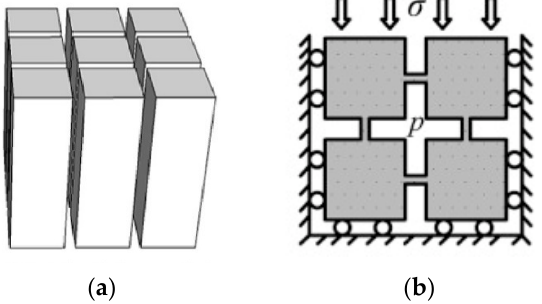
Figure A1. Simplified model of the coal and idealized boundary conditions in a CBM reservoir [54], ( a ) matchstick conceptual model, ( b ) uniaxial strain for a coal seam under constant vertical stress conditions.